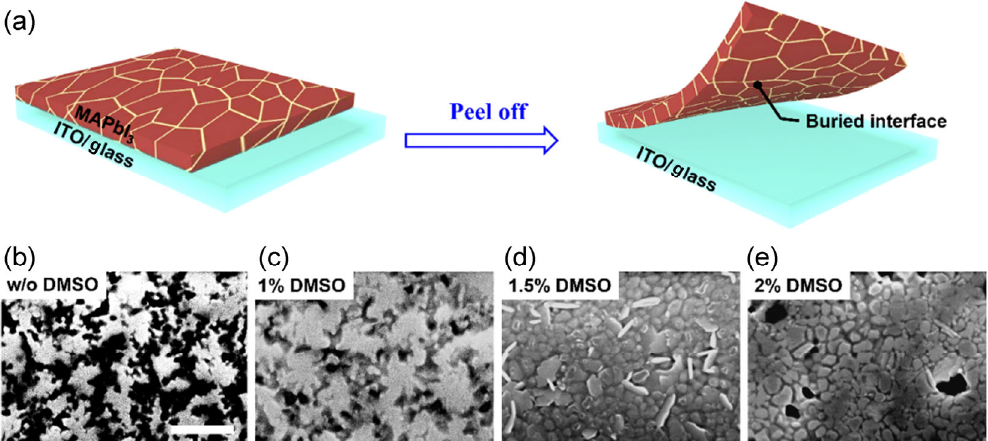
Figure 1 (a) Illustration of the peel-off process to expose buried interface of MAPbI 3 perovskite film. SEM images of the buried interface of the perovskite films fabricated by blade-coating MAPbI 3 precursor solution with DMSO additives: (b) without DMSO additive, (c) with 1% volume ratio, (d) with 1.5% volume ratio, and (e) with 2% volume ratio. The scale bar is 1